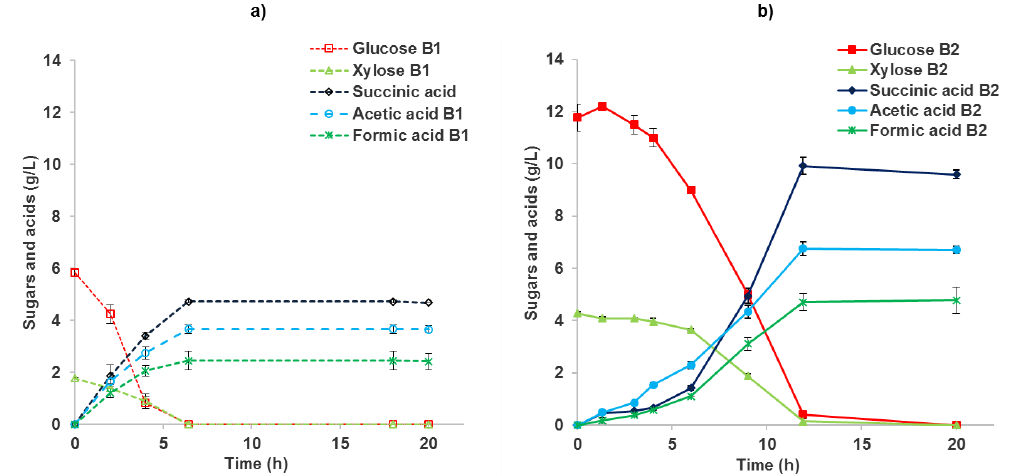
Figure 4. Batch experiments in 2 L bioreactors. A. succinogenes 130Z was grown at 37 °C, pH 6.5 with constant sparging of CO 2 on: ( a ) CSH hydrolysate (90% v / v ) and ( b ) concentrated CSH hydrolysate (180% v / v ).